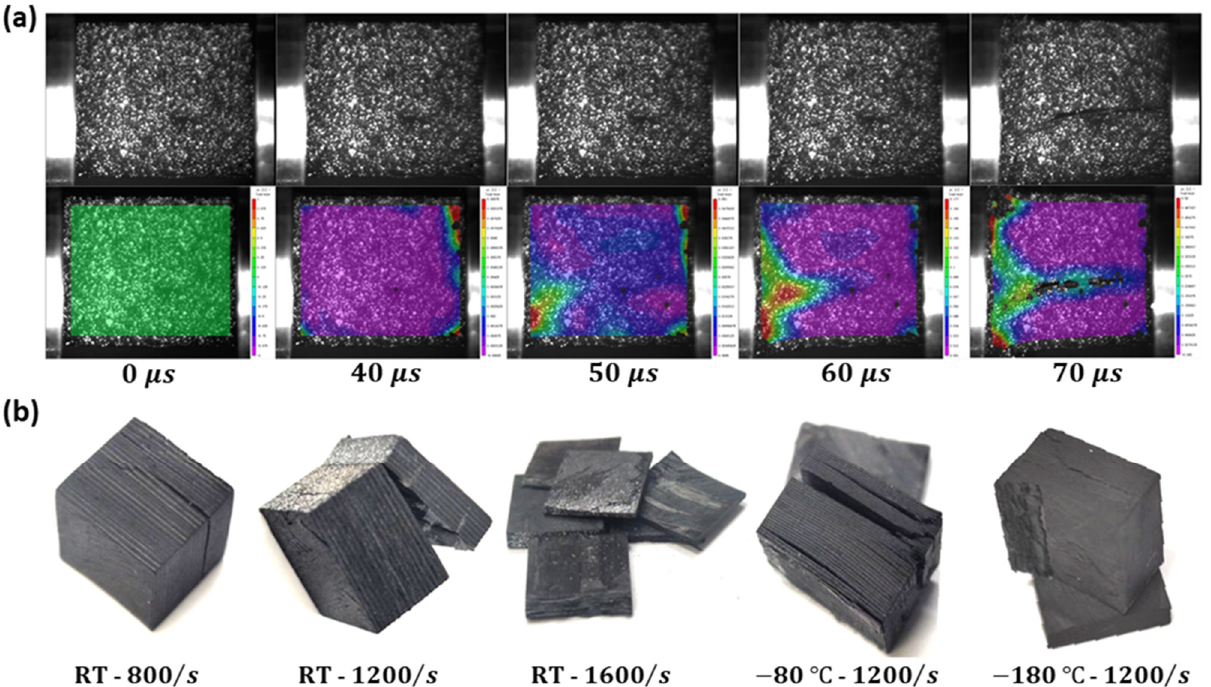
Figure 5. The dynamic compression samples of CFRP laminates: ( a ) the damage evolution process captured by high-speed camera and corresponding DIC analysis results during compression at a 1200/s strain rate; ( b ) the final damage morphology at different temperatures and strain